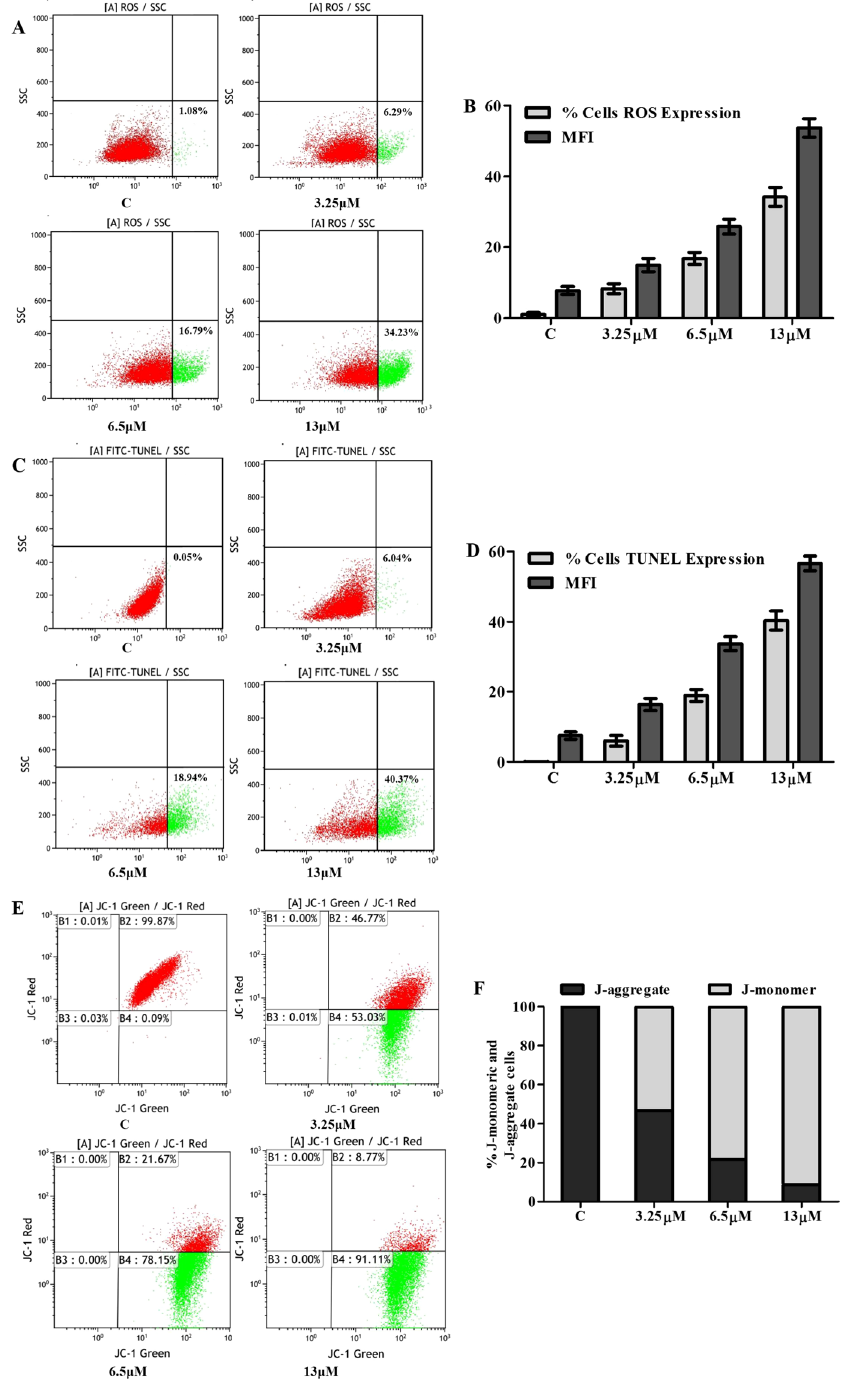
Figure 5. Effect of M22 on intracellular ROS levels, DNA fragmentation and mitochondrial transmembrane permeability (MMP, ΔΨ m) changes. A549 cells incubated with M22 at different concentrations for 48 h were stained with DCFH-DA, fluorescein isothiocyanate-dUTP and JC-1 dye. The signal were assessed from fluorescence by flow cytometry and determined in terms of mean fluorescence intensity (MFI). Dot plots show that ( A ) ROS and ( C ) DNA fragmentation levels increases in a concentration-dependent manner. Bar diagram show that ( B ) percentage of elevated ROS cells, ROS production and ( D ) percentage of cells with TUNEL expression, DNA fragmentation degree increases in a dose-dependent manner. ( E ) Dot plots show that ΔΨ m decreases in a dose-dependent manner. ( F ) Bar diagram showing percentage of apoptotic and nonapoptotic cells are hown on the right side of each